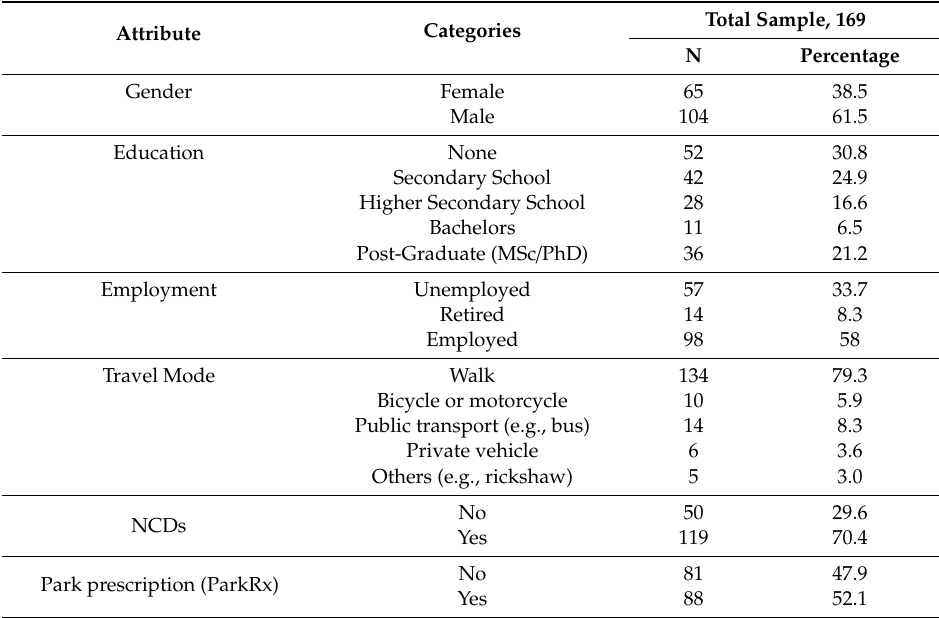
Table 2. Sample characteristics.